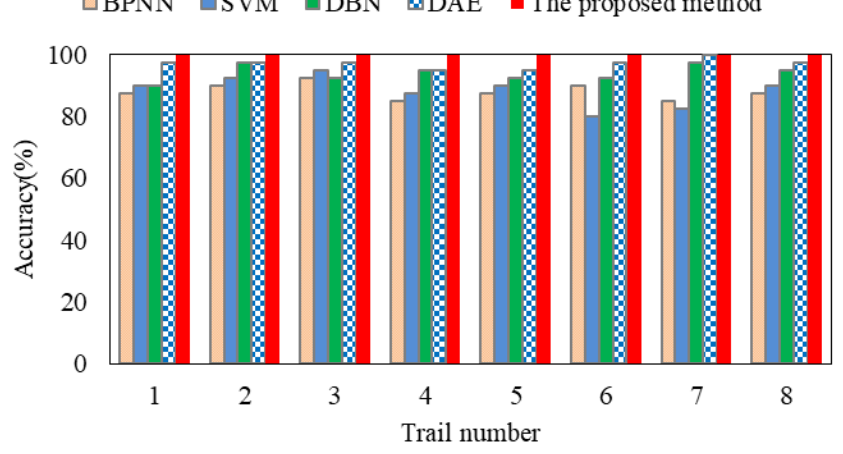
Figure 11. Comparative experiments of four methods.